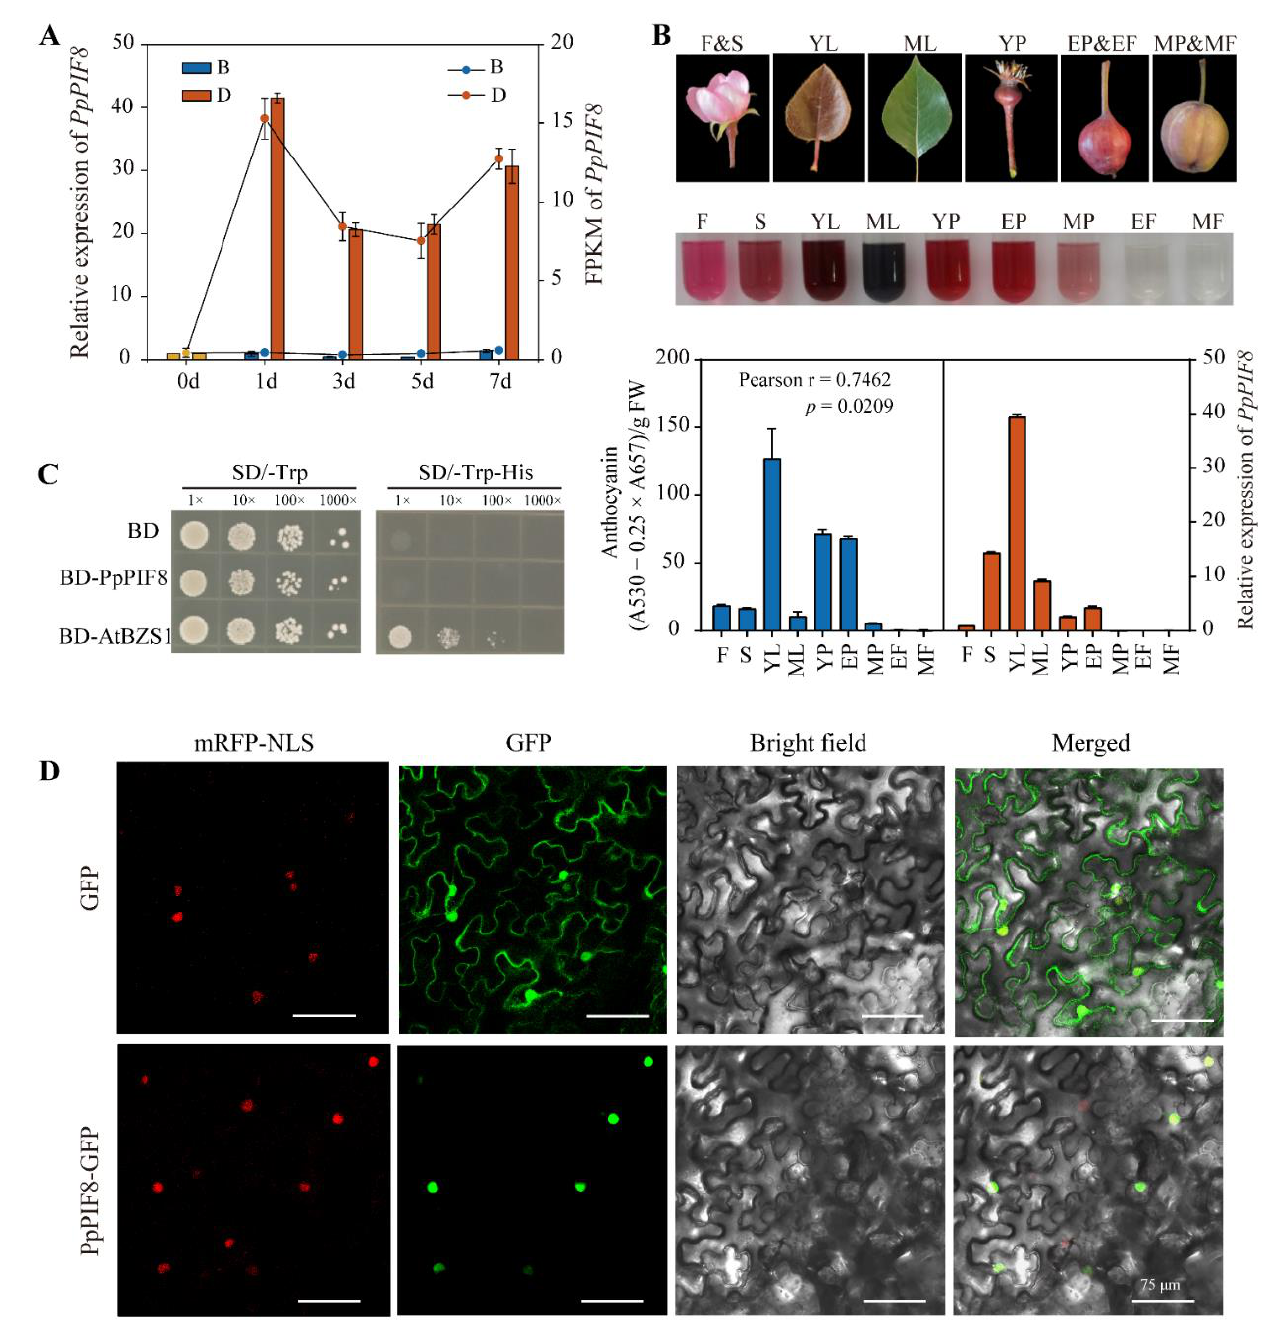
Figure 9. Expression, transcription activation, and subcellular localization of PpPIF8. ( A ) Verification of PpPIF8 expression in RT-qPCR results and RNA-Seq data. ( B ) Expression patterns of PpPIF8 in different tissues. The abbreviation in the graph are as follows: Flower-F, Sepal-S, Young leaf-YL, Mature leaf-ML, Young fruitlet-YF, Expansion stage peel-EP, Expansion stage flesh-EF, Mature stage peel-MP, and Mature stage flesh-MF. ( C ) Transcriptional activation of PpPIF8 using a yeast assay. The GAL4 DNA-binding domain ( B , D ) alone was used as the negative control. The BD-AtBZS1 was used as the positive control. SD/ − Trp, synthetic dextrose medium lacking Trp; SD/ − Trp-His, synthetic dextrose medium lacking both Trp and His. ( D ) Subcellular localization of PpPIF8 in Nicotiana benthamiana leaf cells. Scale bar: 75 µ